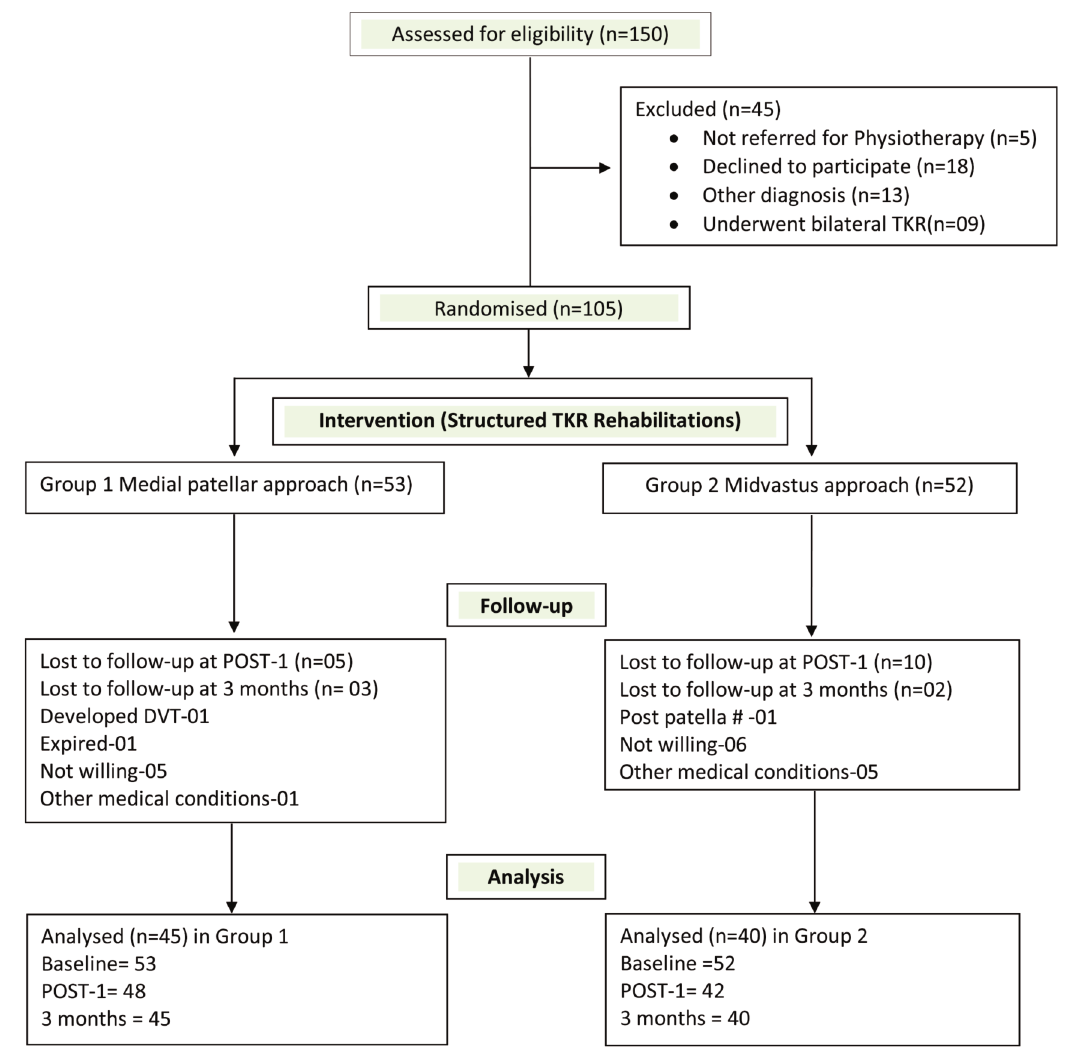
Consort flow Fig. 1: